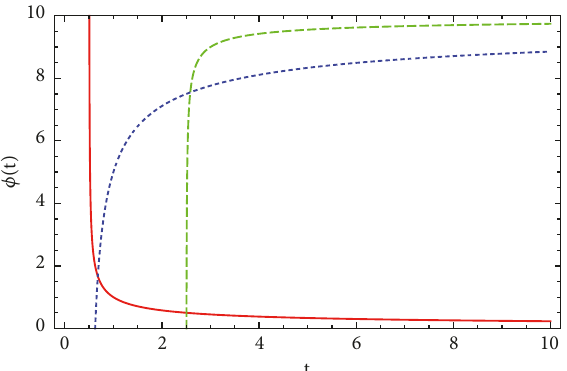
Figure 1: Case I: time evolution of 𝜙 . Dotted (blue) line stands for 𝛽 = 1 , 𝛾 = 10 , and 𝛿 = 5 , while for the dashed (green) line and 1 1 1 solid (red) line, 𝛽 1 = 5 , 𝛾 1 = 10 , and 𝛿 1 = 1 and 𝛽 1 = 1 , 𝛾 1 = 0 , and = −1 , 𝛿 1